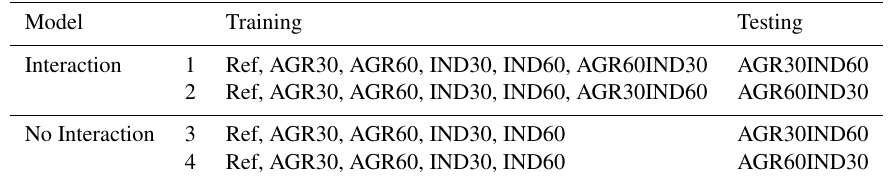
Table 2. List of CTM sensitivity simulations used to train and test the need to account for interactions in the quadratic forms of the surrogate model.